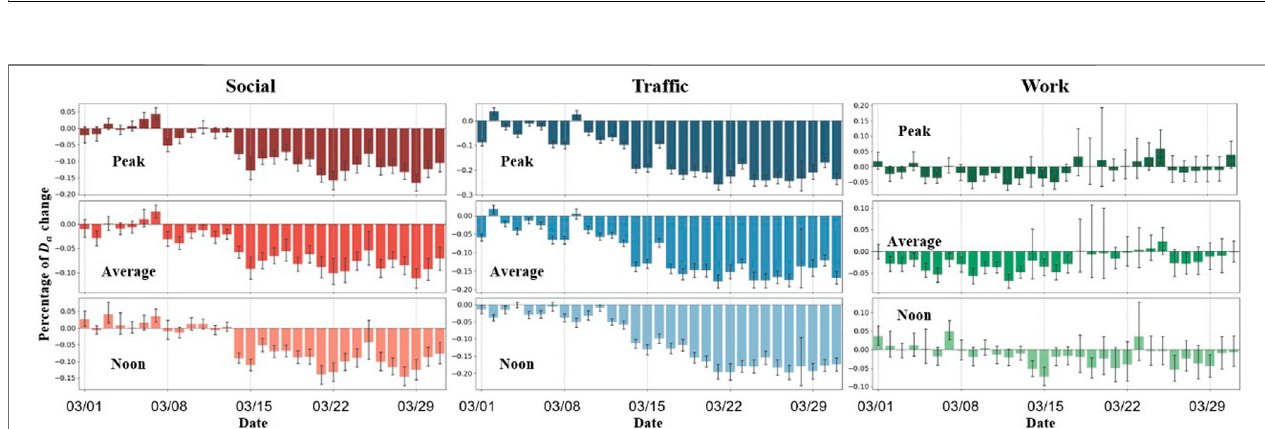
FIGURE 3 | The percentage change of D v for 193 counties in March 2020. The height of each bar is the average percentage change of all 193 counties. The error barindicatesthestandarddeviationamongallcounties.Thethreetilecategoriesofsocial,traf fi c,andworkareshownineachcolumn,andthreedailytileaggregationsof peak, average, and noon are shown in each row.